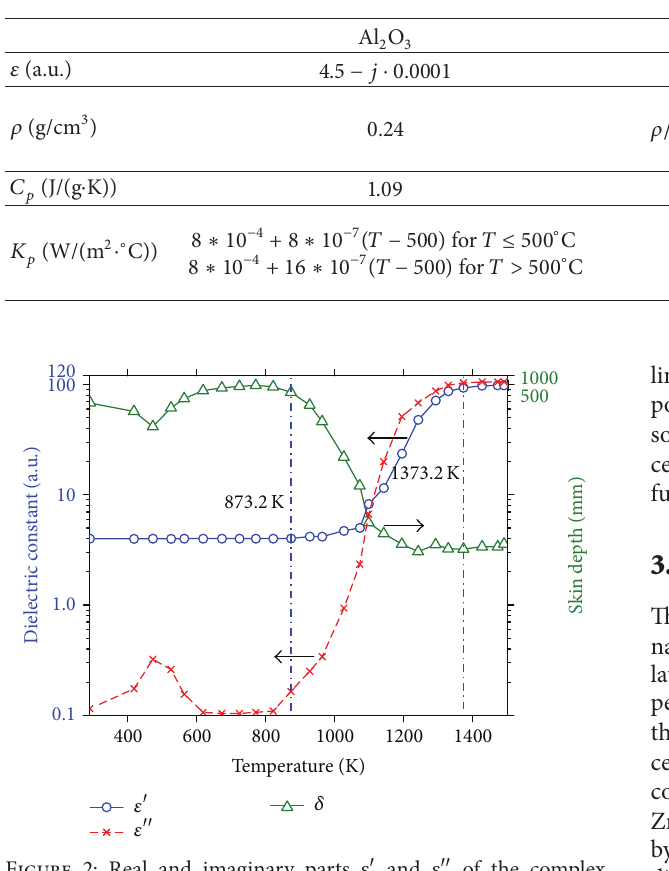
Figure 2: Real and imaginary parts 𝜀 󸀠 and 𝜀 󸀠󸀠 of the complex dielectric constant and the skin depth 𝛿 of ZnO versus temperature 𝑇 at 2.45